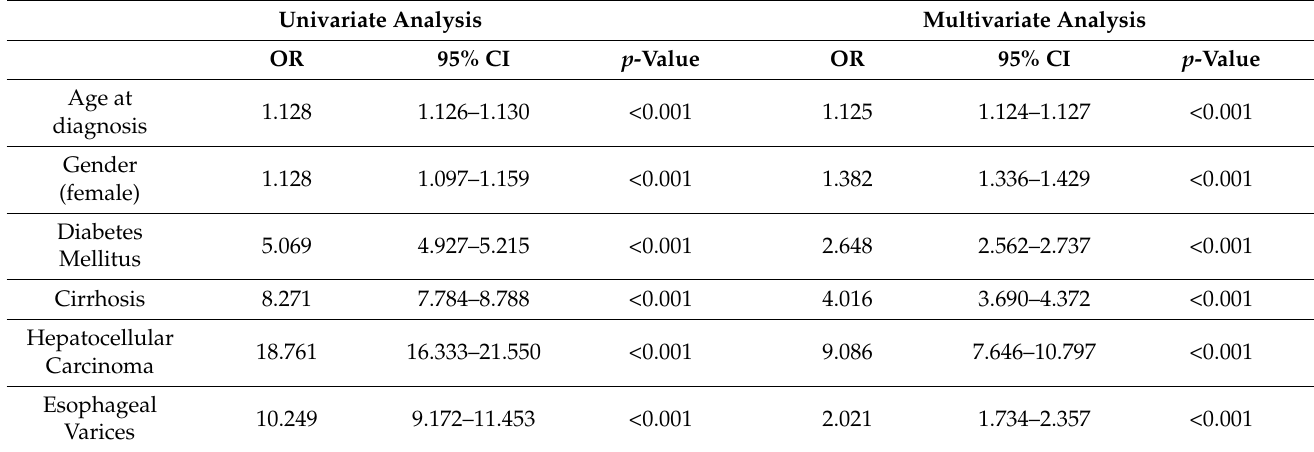
Table 7. Univariate and multivariate analyses of risk factors for death among NAFLD patients. Univariate Analysis Multivariate